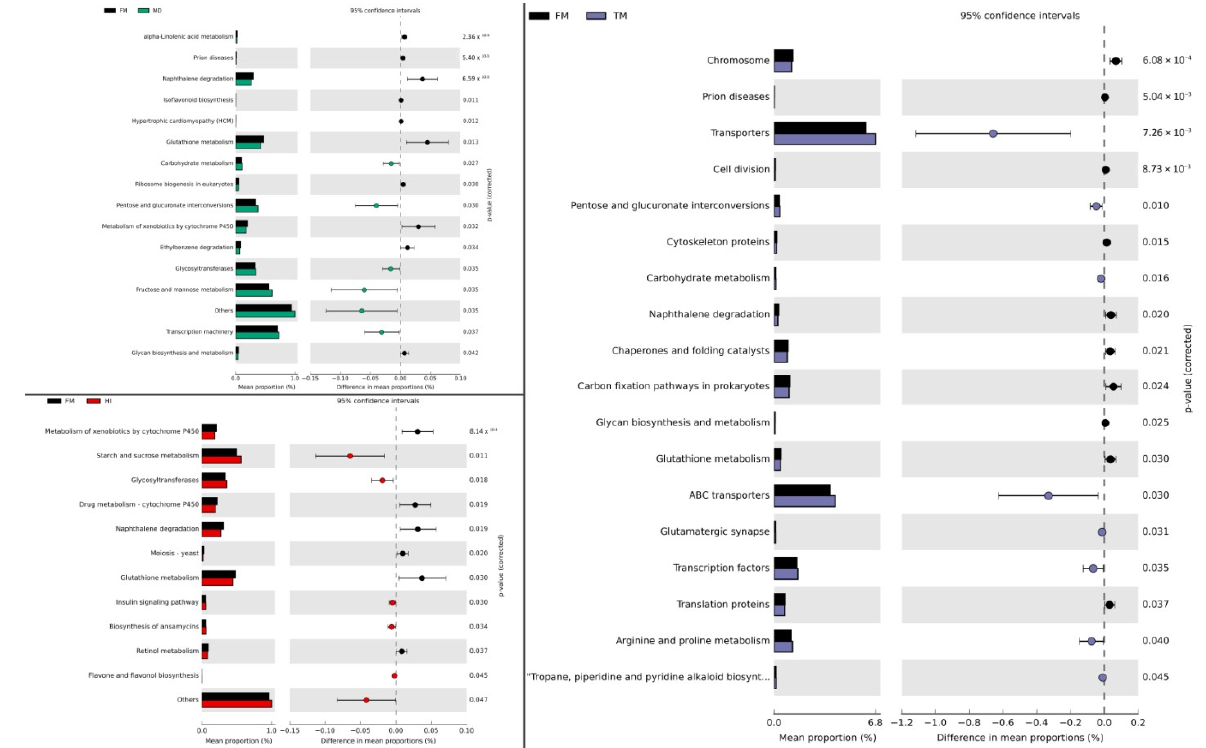
Figure 5. Significantly altered bacterial Kyoto Encyclopedia of Genes and Genomes (KEGG) pathways at level 3 (Welch’s t -test, p < 0.05) between fish meal (FM) and insect meal (HI, TM, MD) diets fed to Dicentrarchus labrax . Predicted functional pathways based on differential abundance were generated by PICRUSt and STAMP analyses. Significant differences were calculated using the Welch’s inverted confidence interval method. Abbreviations according to Figure 1.